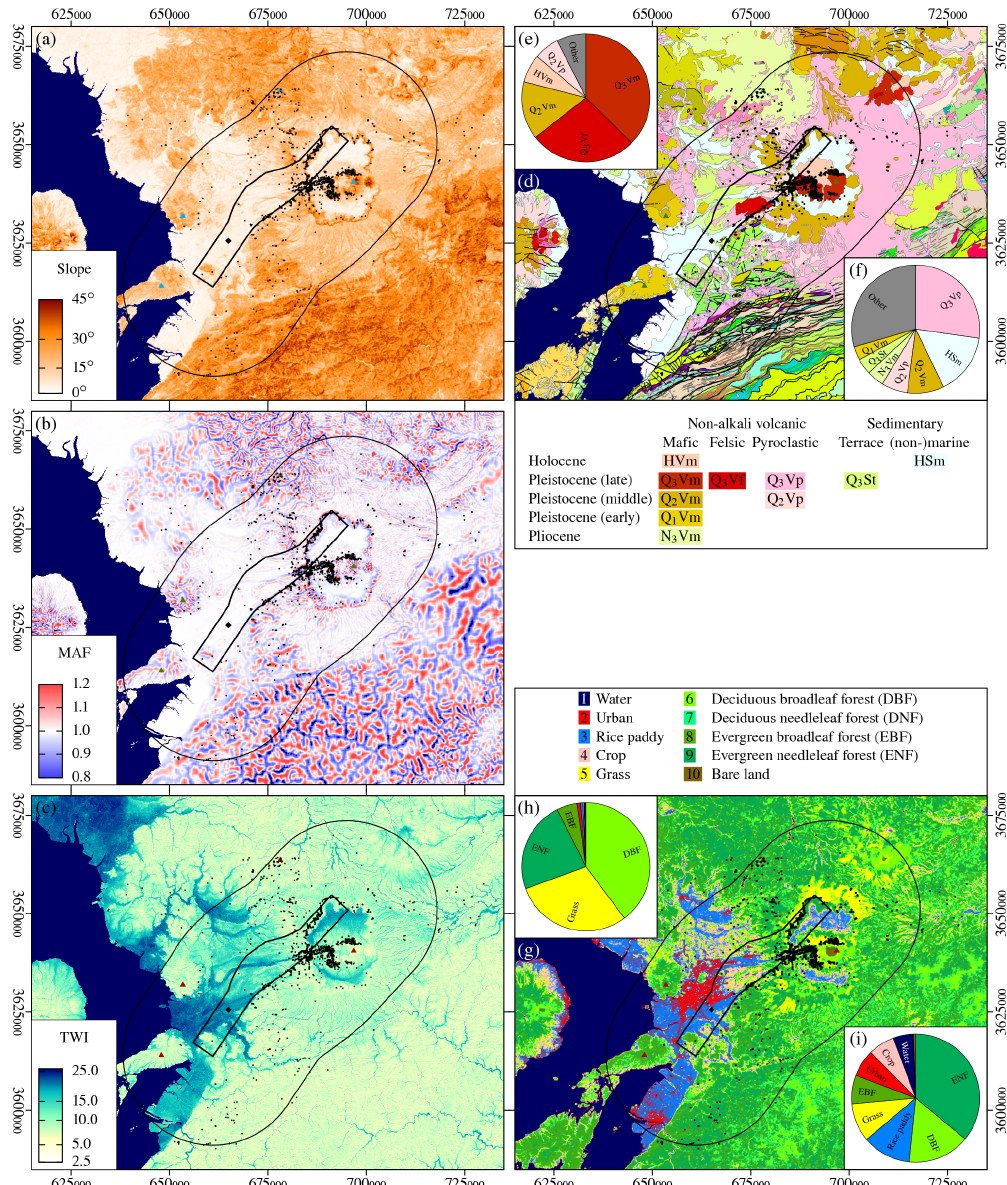
Figure 2. Topographic and geological features of central Kyushu with landslides (black dots), landslide-affected area (outer black line), rupture area (inner black line), hypocentre (black diamond), and mountain peaks from Fig. 1 (triangles). (a) Hillslope inclination. (b) Median amplification factor (MAF). (c) Topographic wetness index (TWI). (d) Geology of central Kyushu. The most common geological units of the landslides are shown in (e) . For the landslide-affected area the dominant geological units are in (f) . (g) Land cover. Land cover in the landslide areas is shown in (h) and is shown for the entire landslide-affected area in (i)